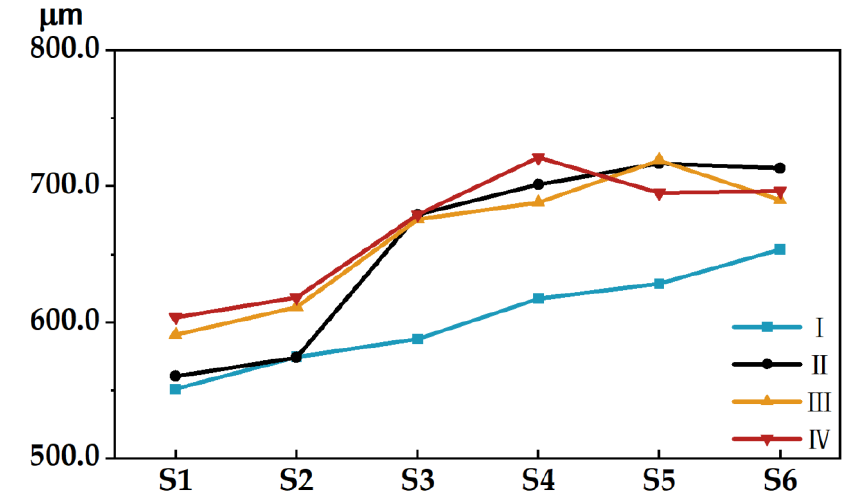
Figure 3. Average depth of pigment penetration on the side of each 3D test